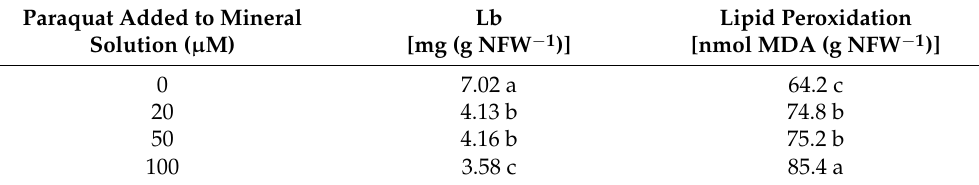
Table 5. Effect of paraquat addition on leghaemoglobin (Lb) content and lipid peroxidation in nodules of soybeans plants inoculated with B. diazoefficiens 110 spc 4 treated or not with paraquat. Paraquat Added to